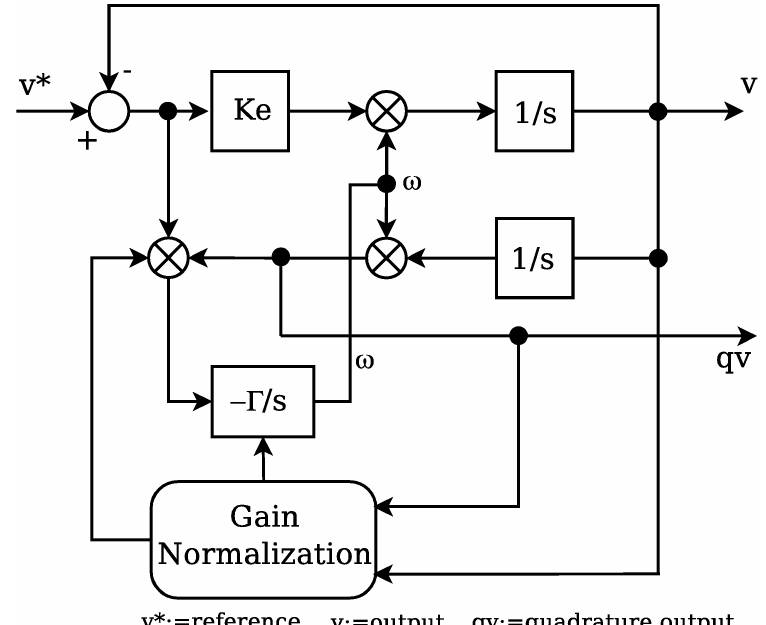
Scheme of the SOGI-FLL system (The gain normalization block provides (cid:112) 1 / v 2 + qv 2